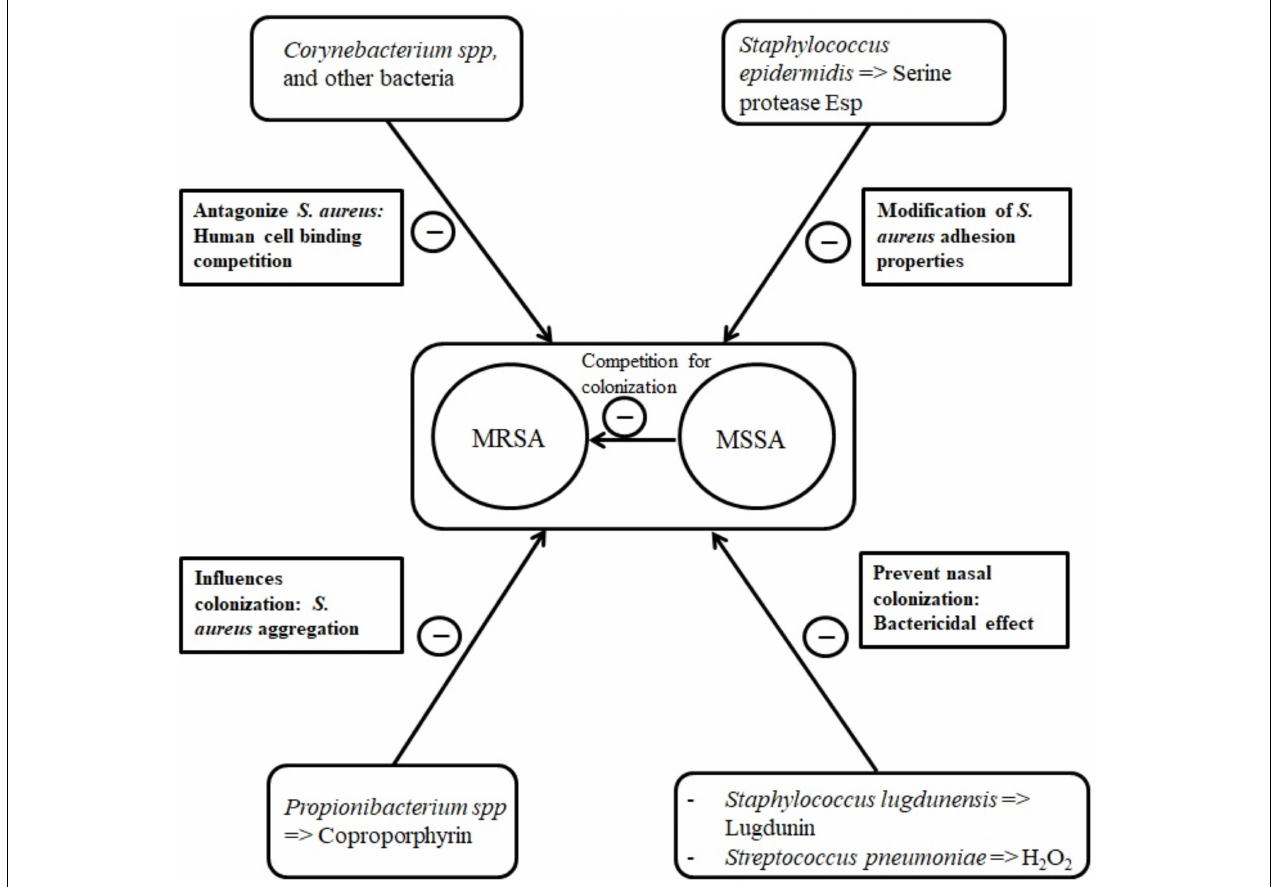
FIGURE 1 | Main bacterial interactions with nasal S. aureus .